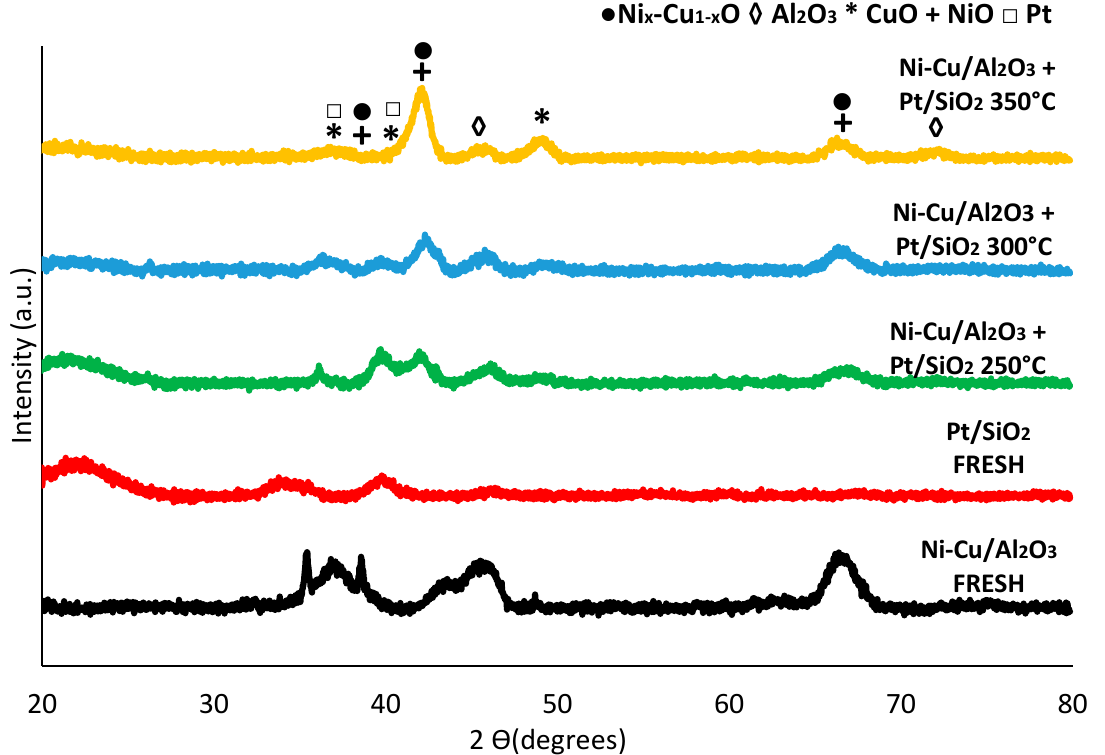
Figure 11. XRD of the fresh and recovered Ni ‐ Cu/Al 2 O 3 + Pt/SiO 2 .